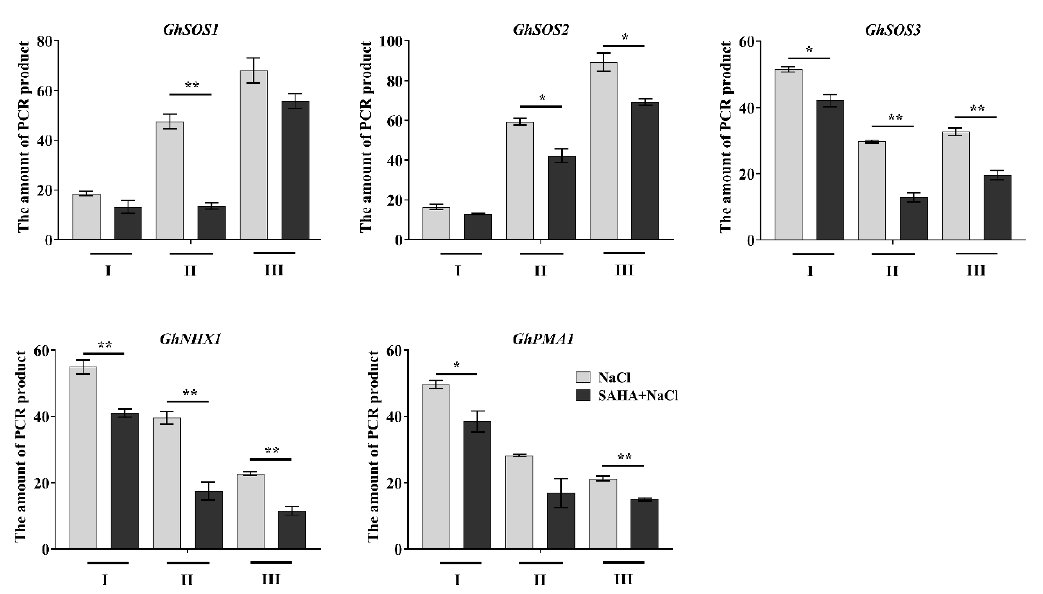
Figure 6. Effects of SAHA pretreatment on the chromatin accessibility of promoter regions of GhSOS1 , GhSOS2 , GhSOS3 , GhNHX1 , and GhPMA1 in leaves under 250 mM NaCl stress for 0.5 h. CHART-PCR assay was carried out to measure the sensitivity of the promoter regions of the ion homeostasis-related genes to micrococcal nuclease (MNase). Detected regions (I, II, and III) were same as those used in the ChIP-qPCR assay. The Ct values were converted to the amounts of PCR product according to the standard curve. Values represent the means ± SD of three biological replicates. Student’s t -test, * p < 0.05, ** p < 0.01.